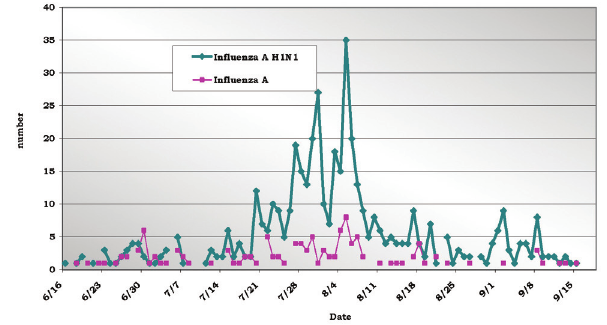
100Figure 3 - Distribution of confirmed cases of seasonal Influenza A and Influenza A (H1N1) admitted in the HC-FMUSP - 06/16 to 09/18 - 2009